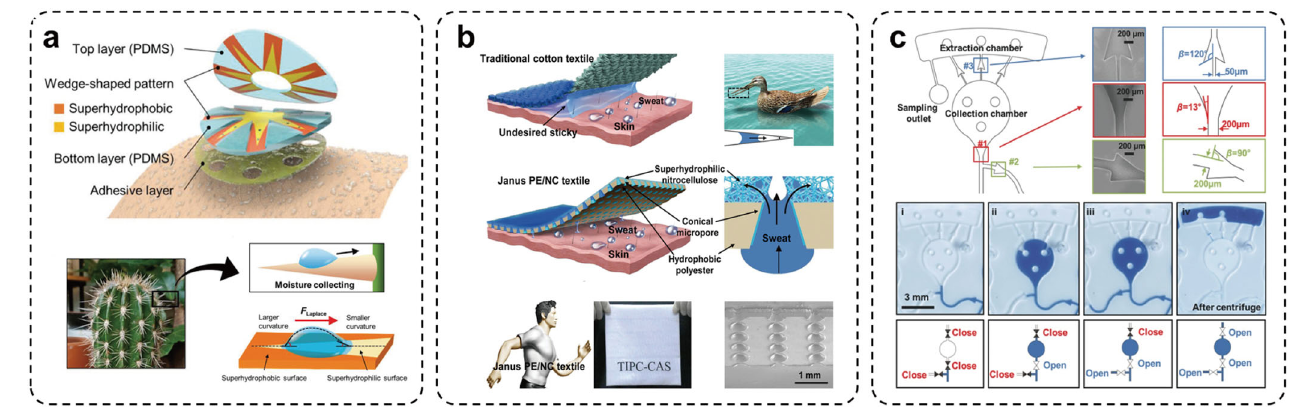
Fig. 3 Examples of sweat collecting and control. ( a ) A sweat-collecting patch that can collect sweat ef fi ciently for fast and continuous healthcare monitoring. Ref. 63 , Copyright 2021, Advanced Materials. ( b ) A hydrophobic/superhydrophilic Janus polyester/nitrocellulose textile embedded with a conical micropore array that has a hydrophilic inner surface. Ref. 64 , Copyright 2019, Advanced Materials. ( c ) A thin, soft, skin-like micro fl uidic platform that bonds to the skin to allow for the collection and storage of sweat in an interconnected set of micro reservoirs. Ref. 69 , Copyright 2017, Advanced Healthcare